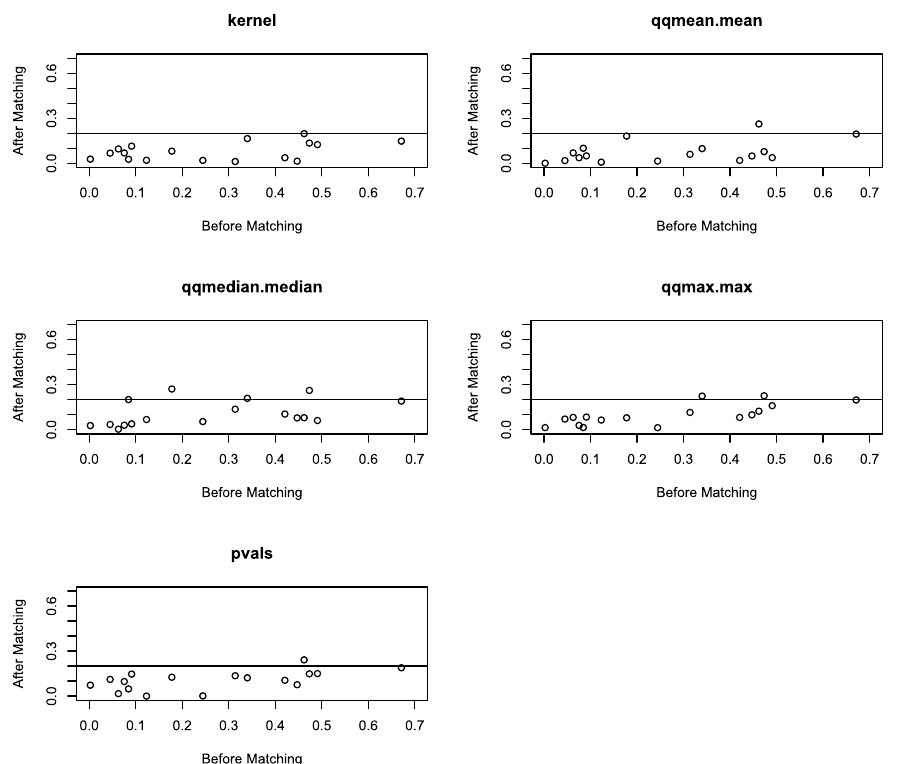
Figure 1: ASMD values before and after matching for different balance metrics in genetic